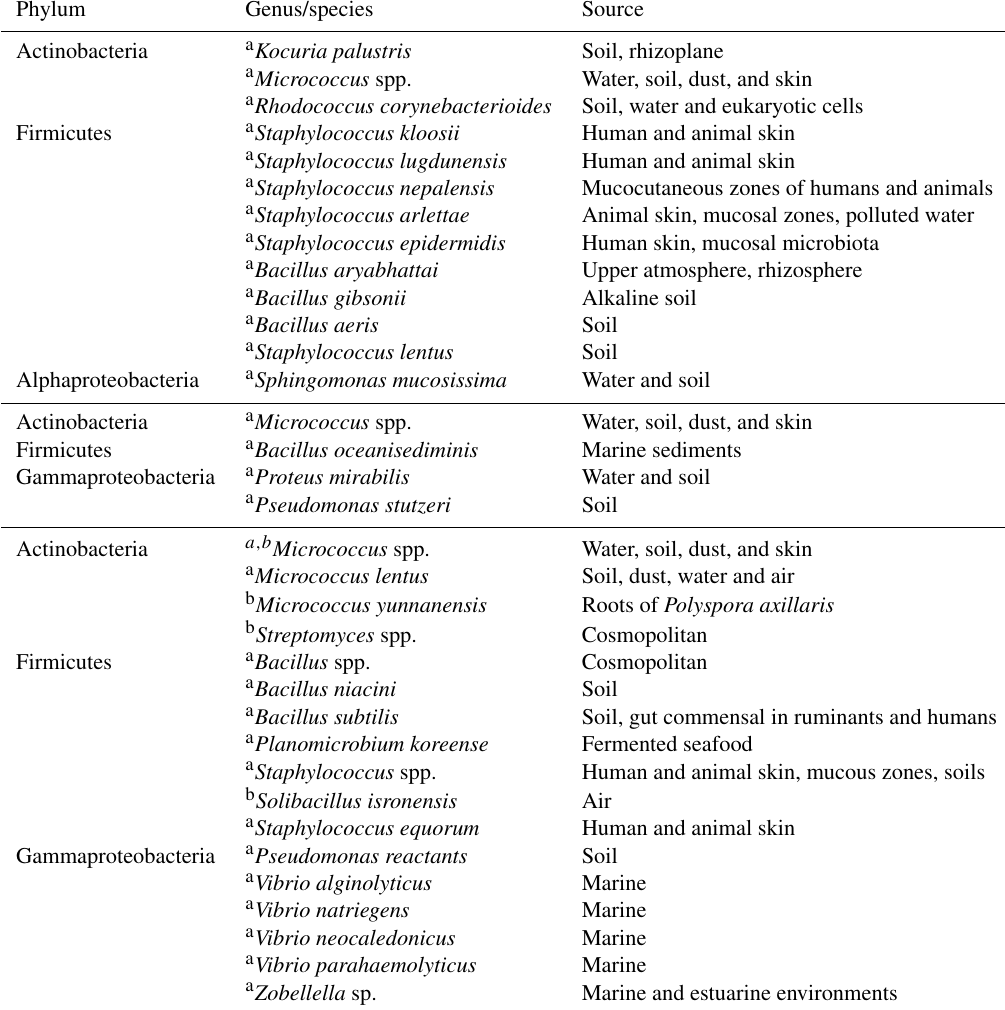
Table 3. Bacterial isolation for (top) 21–22 January, (middle) at cold front A and (bottom) cold front B.